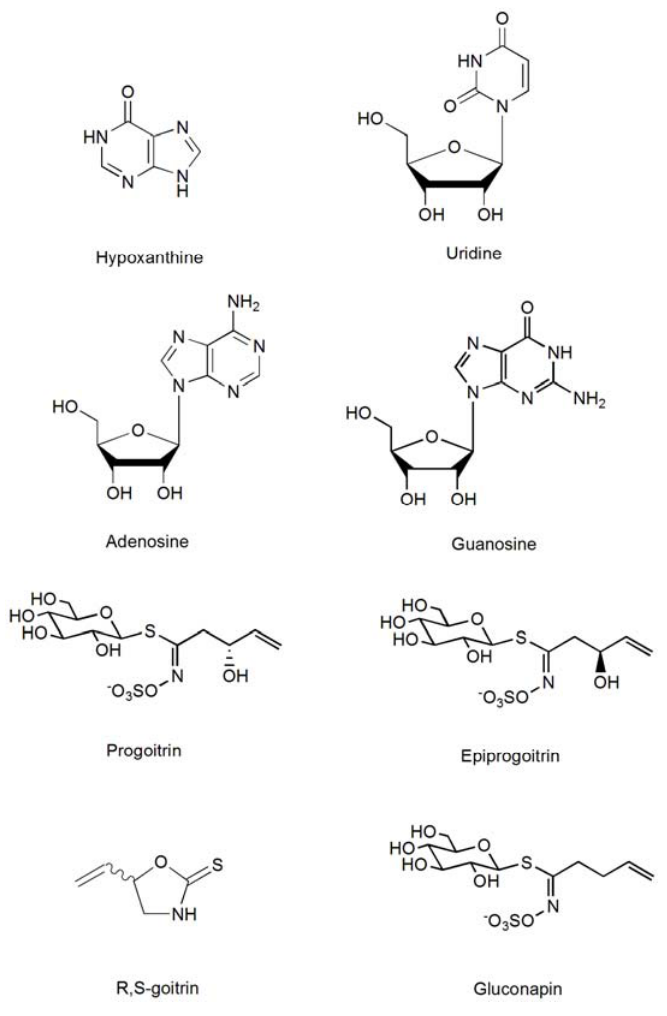
Figure 6. The structures of eight bioactive components in Radix